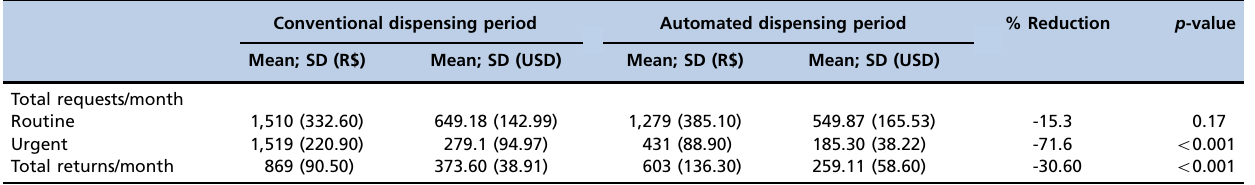
Table 3 - Urgent and routine requests as well as pharmaceutical product returns to the central pharmacy at Hospital Sı´rio-Libaneˆs before and after implementing the automated medication dispensing system. 2013-2014. Sa˜o Paulo, Brazil.